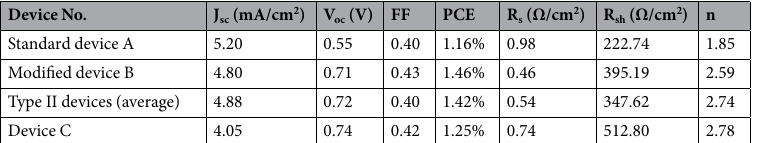
Table 1. Photovoltaic performance and extracted parameters of